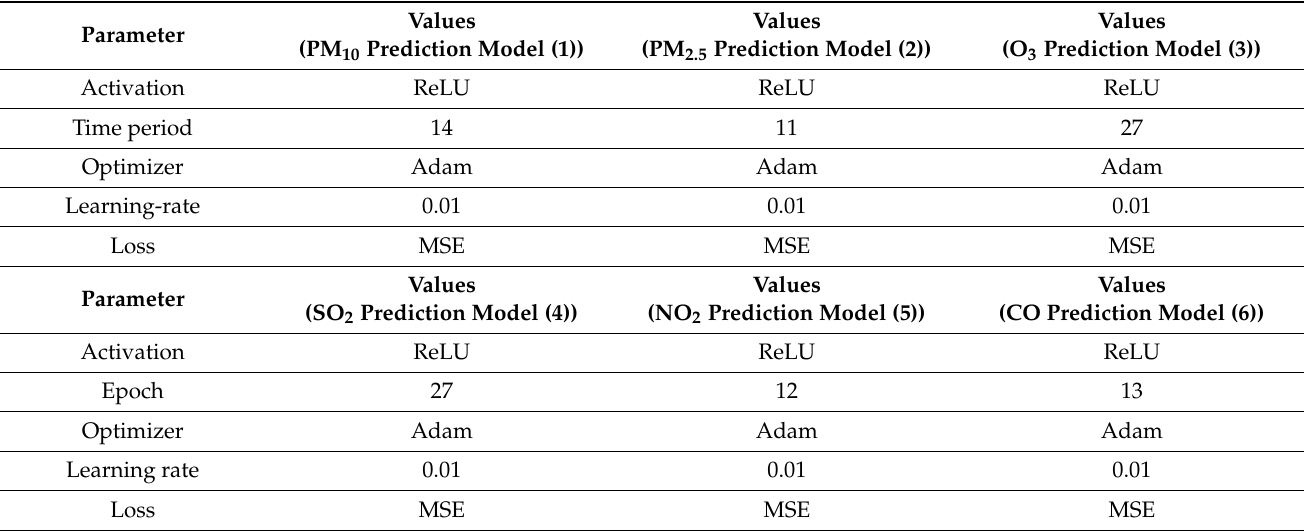
Figure 6. Construction of links in station network. Black pentagonal points represent six pollutant stations located in a neighboring city, and black lines represent six pollutant stations connected in neighboring stations. Table 2. Setting of parameters in LSTM. Each of the six pollutants from the station is predicted using each of the six pollutants’ data as an independent variable (pollutant prediction models). The six pollutants are fine dust (PM 10 ), fine particulate matter (PM 2.5 ), ozone (O 3 ), sulfurous acid gas (SO 2 ), nitrogen dioxide (NO 2 ), and carbon monoxide